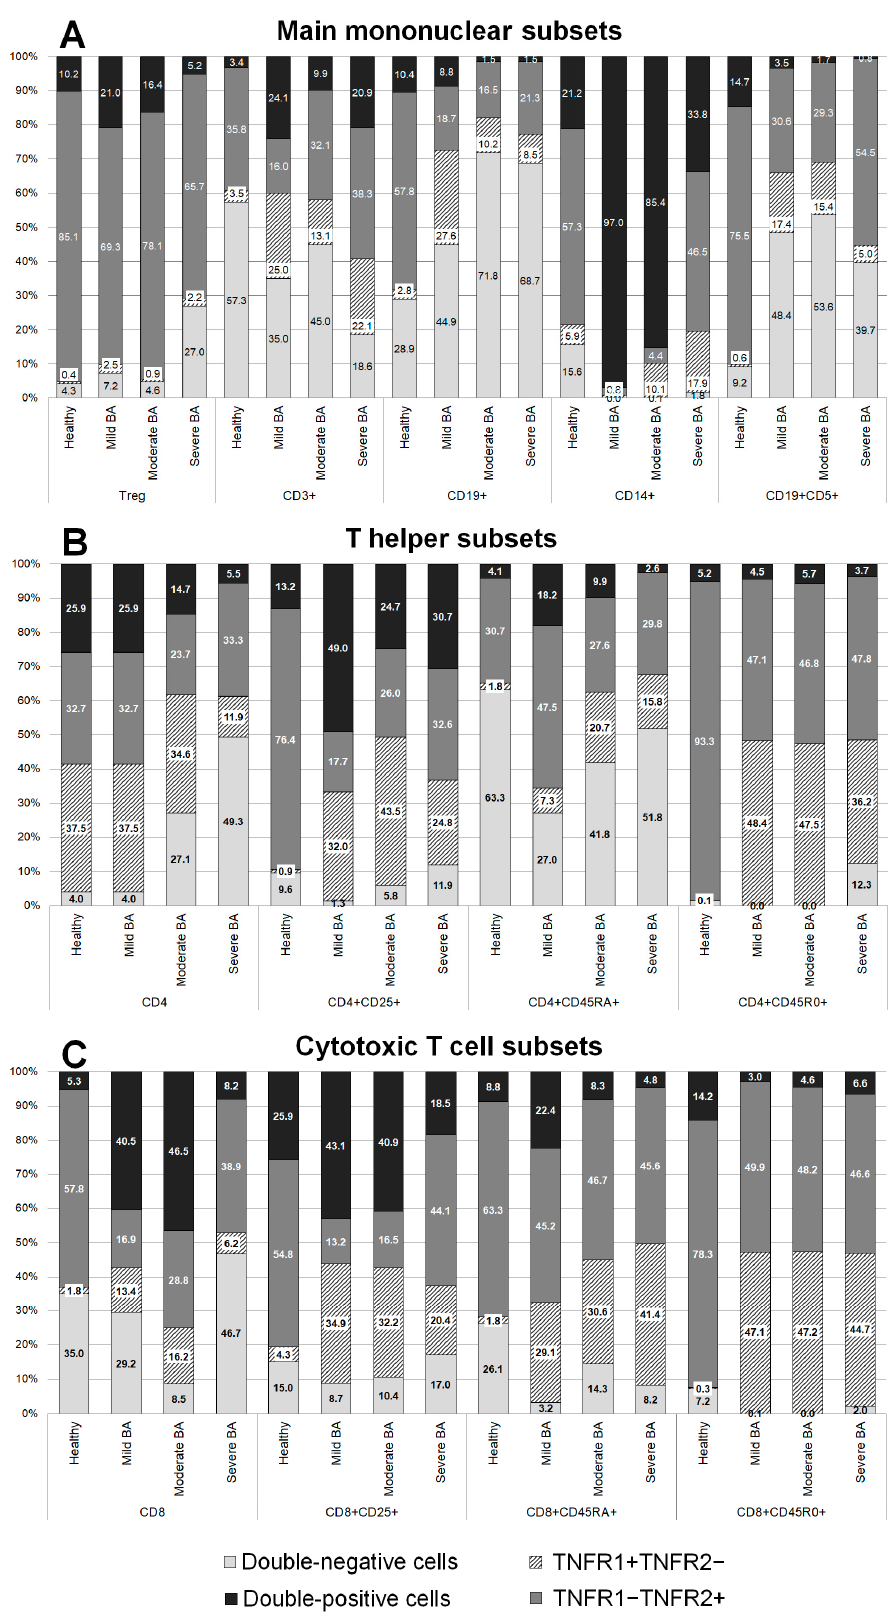
Figure 1. Distribution of TNFR1 and TNFR2 co-expression among main mononuclear subsets ( A ), among T helper subsets ( B ), and among cytotoxic T cell subsets ( C ) .